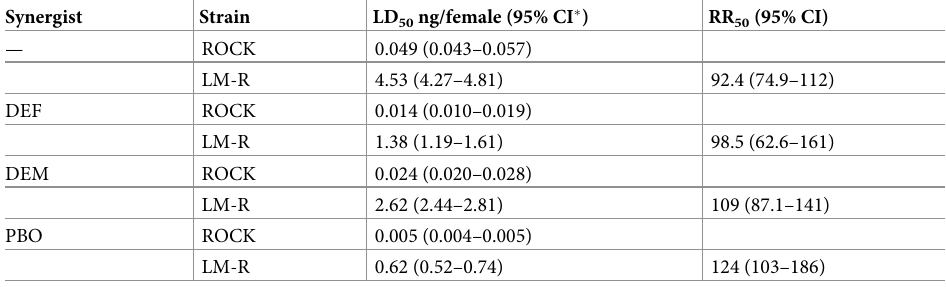
Table 2. Bioassays using synergists and cyhalothrin to adult females of the ROCK and LM-R strains.